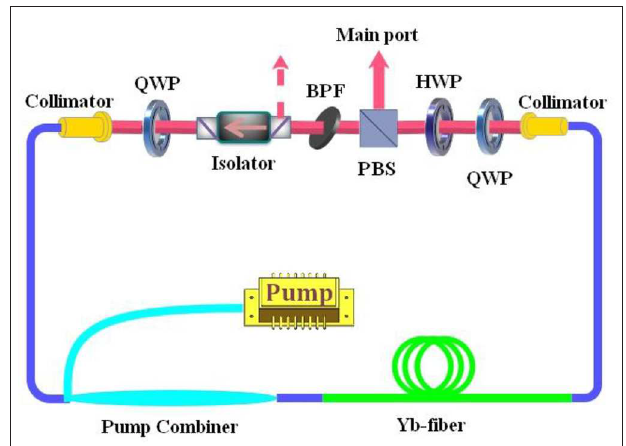
FIGURE 1 | Schematic of the power-scaled dissipative soliton mode-locking fiber laser. QWP, quarter-wave plate; BFP, birefringent plate; PBS, polarizing beam splitter; HWP, half-wave plate; PS-ISO, polarization-sensitive isolator.